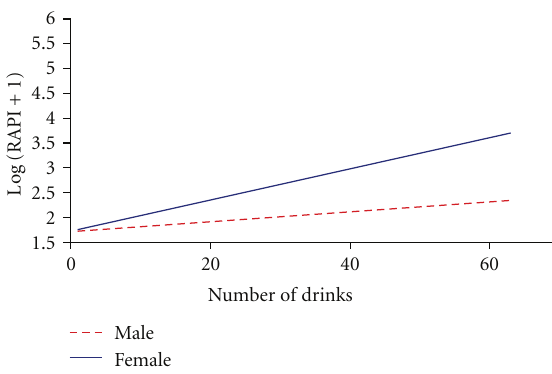
Figure 3: Association of RAPI to drinking amount and